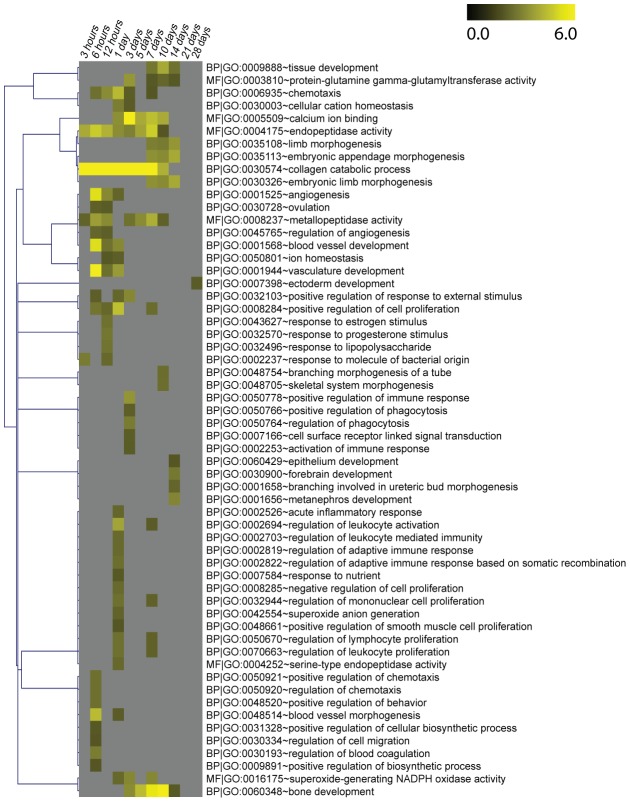
Gene ontology (GO) analysis of the time course.GO enrichment of molecular function (MF) and biological process (BP) level 5 GO terms during the time course for all DE genes (relative to the zero hour control). The value displayed is the −log10(GO term FDR). GO terms with an FDR<0.01 are shown. The GO terms were clustered by their enrichment patterns using the Pearson correlation as the distance measure with average linkage. During the first day enriched GO terms include GO terms representing immune response, chemotaxis, regulation of leukocytes, blood vessel development, and angiogenesis. In the middle of the time course (3 d–14 d), GO terms for tissue development, limb morphogenesis, bone development, and forebrain development are enriched. An ectoderm development GO term is enriched at 28 days. (Detailed GO enrichment information for upregulated axolotl genes is available at www.axolomics.org). (See also Table S4 for the −log10(GO term FDR) values.)